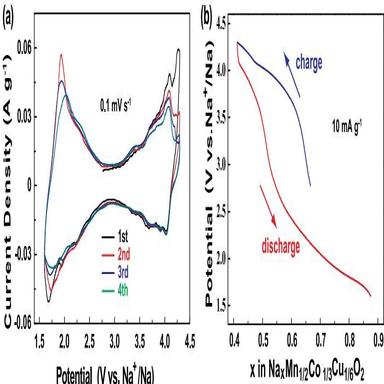
(a) CV curves of the initial four cycles for the P2-MCC at 0.1 mV s1 . (b) The galvanostatic charge/discharge curves of the 1st cycle for the P2-MCC material at current density of 10 mA g1 .